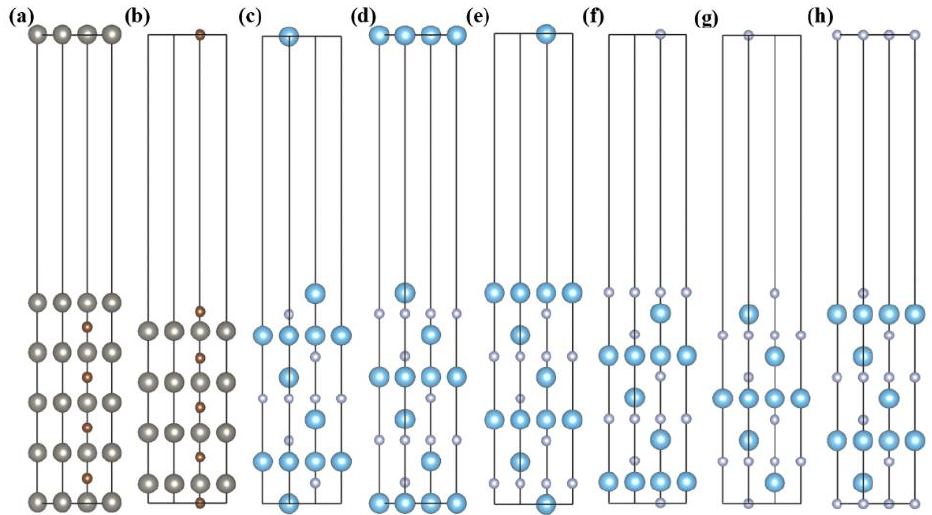
Figure 6. Surface models of ( a ) WC(0001) W-terminated; ( b ) WC(0001) C-terminated; ( c ) TiN(111) Ti1-terminated; ( d ) TiN(111) Ti2-terminated; ( e ) TiN(111) Ti3-terminated; ( f ) TiN(111) N1-terminated; ( g ) TiN(111) N2-terminated; ( h ) TiN(111) N3-terminated.